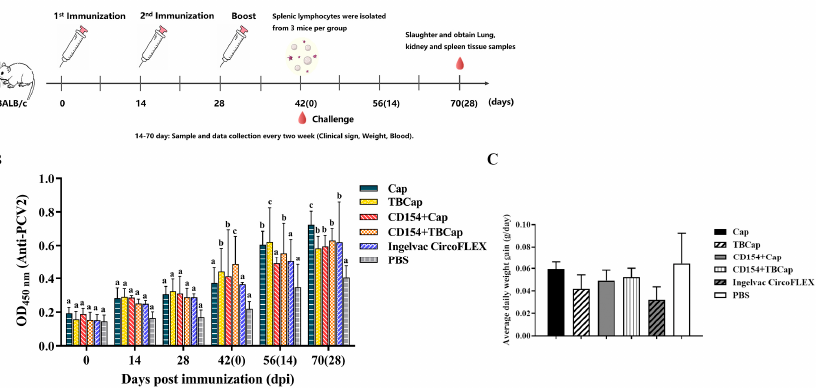
Figure 7. Immunization strategies and immunogenicity in mice. ( A ) Mice immunization strategy. ( B ) ELISA for PCV2-specific antibodies in mice after immunization. ( C ) ADWG of mice after challenge. Different superscripts (a, b, c) indicate statistically significant differences in lymph node viral load between the test groups ( p < 0.05).